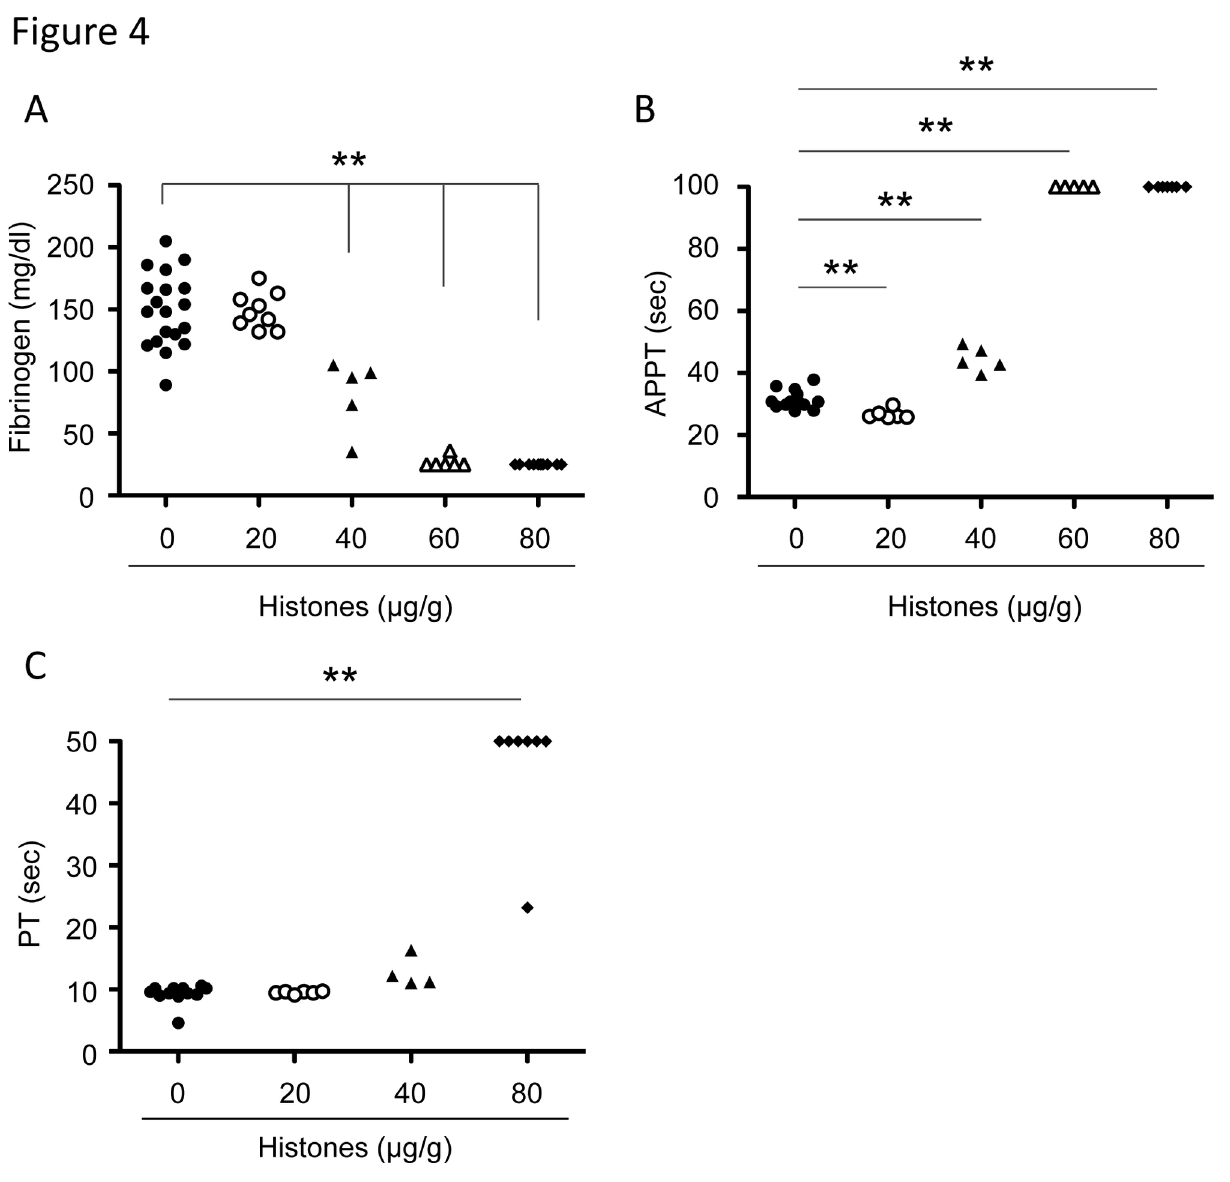
Figure 4. Extracellular histones cause consumptive coagulopathy. Plasma fibrinogen (A), APTT (B), and PT (C) of mice 10 minutes after injection with vehicle or histones (20-80 µg/g, n = 4-10). ** P < 0.01 compared with the vehicle group.